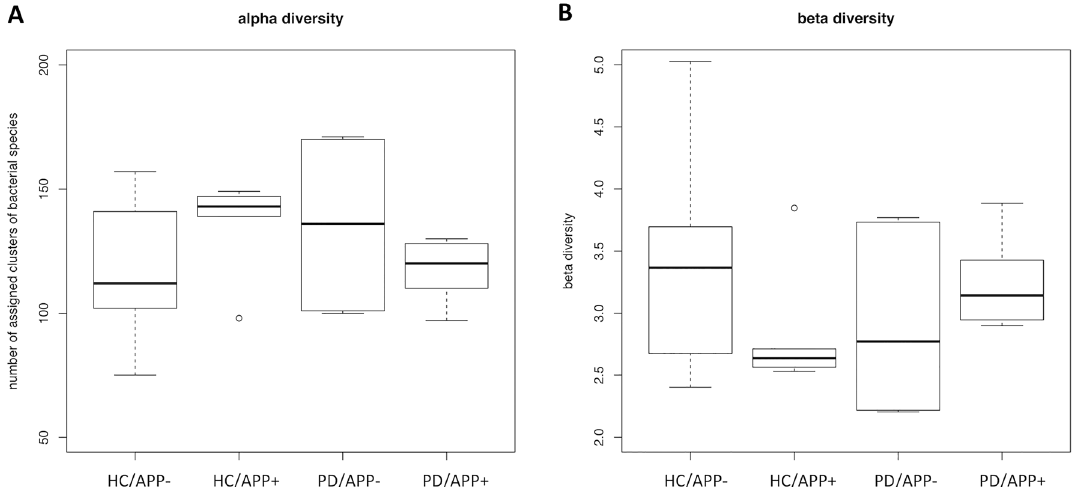
Figure 2. Species diversity analysis. The variances in the alpha and beta diversities of participants without a history of appendectomy (APP) were higher than that in participants with a history of APP. There was no significant difference between the two groups; the p -values of the alpha and beta diversities were 0.095 and 0.095, respectively. HC/APP−, control without history of APP; HC/APP+, control with history of APP; PD/ APP−, patient with PD without a history of APP; PD/APP+, patient with PD with a history of